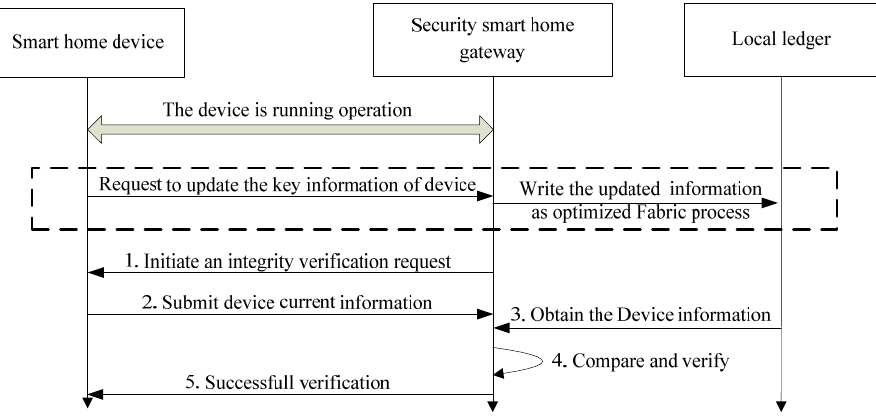
Figure 9. Processing of security control during the operation of the device.